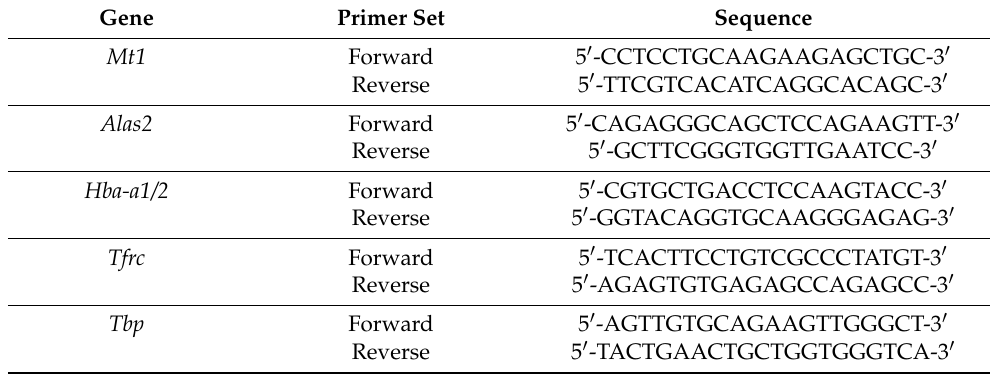
Table 1. qPCR Primer